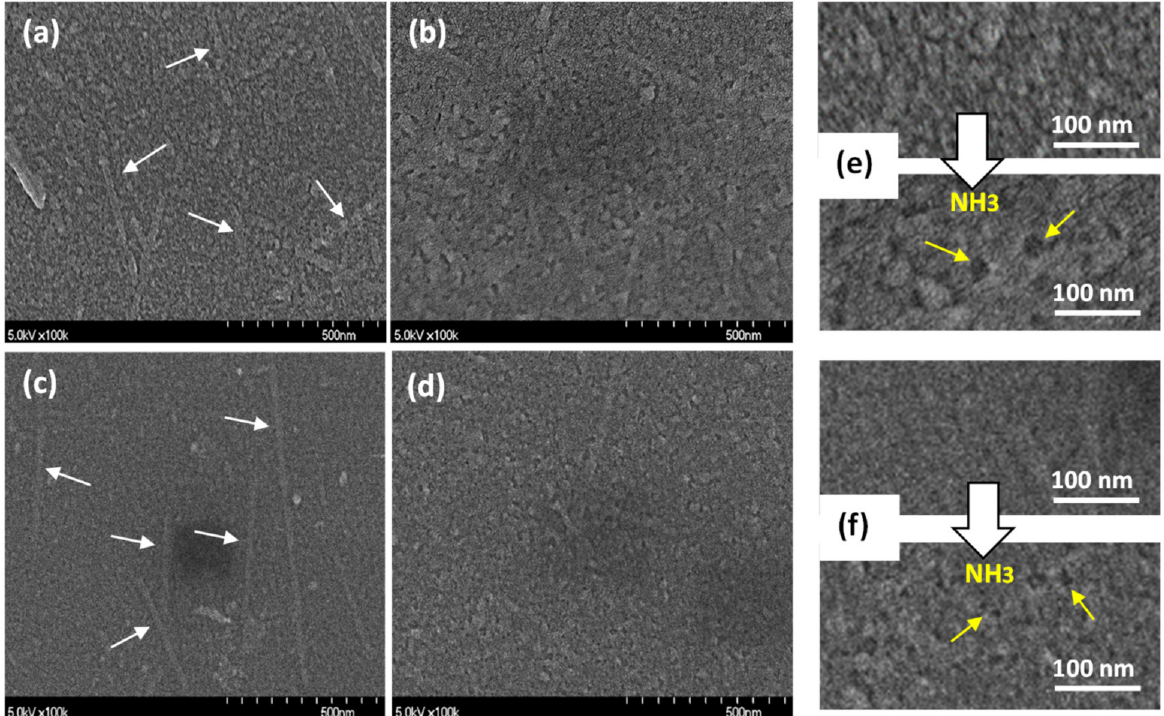
Figure 8. SEM images of ( a , b ) 5-cycle DAR/TSPP and (c and d) 5-cycle DAR/TSPP+PSS (0.025 wt%) films deposited on silicon wafer substrates (a and c) before exposure and ( b , d ) after exposure to 10,000 ppm (sol) ammonia gas for 2 min. The arrows in white in ( a , c ) point to TSPP J-aggregates. Magnified SEM images showing dozens of holes (see arrows in yellow in both cases) after ammonia gas exposure in the sensor films ( e ) without PSS and ( f ) with PSS (0.025